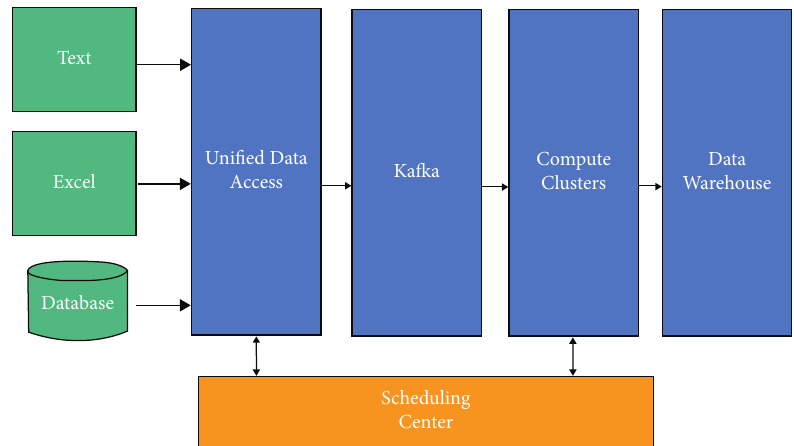
Figure 2: Stream data cleansing